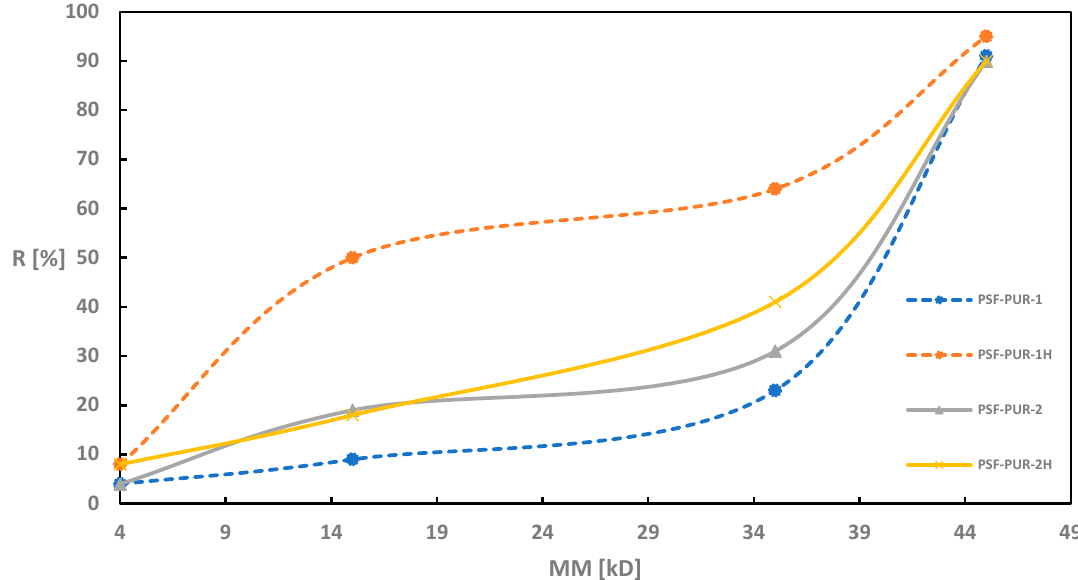
Figure 2. Retention coefficient values for different markers for PSF-PUR-1 and PSF-PUR-2 membranes before (PSF-PUR-1, PSF-PUR-2) and after (PSF-PUR-1H, PSF-PUR-2H) hydrolysis.